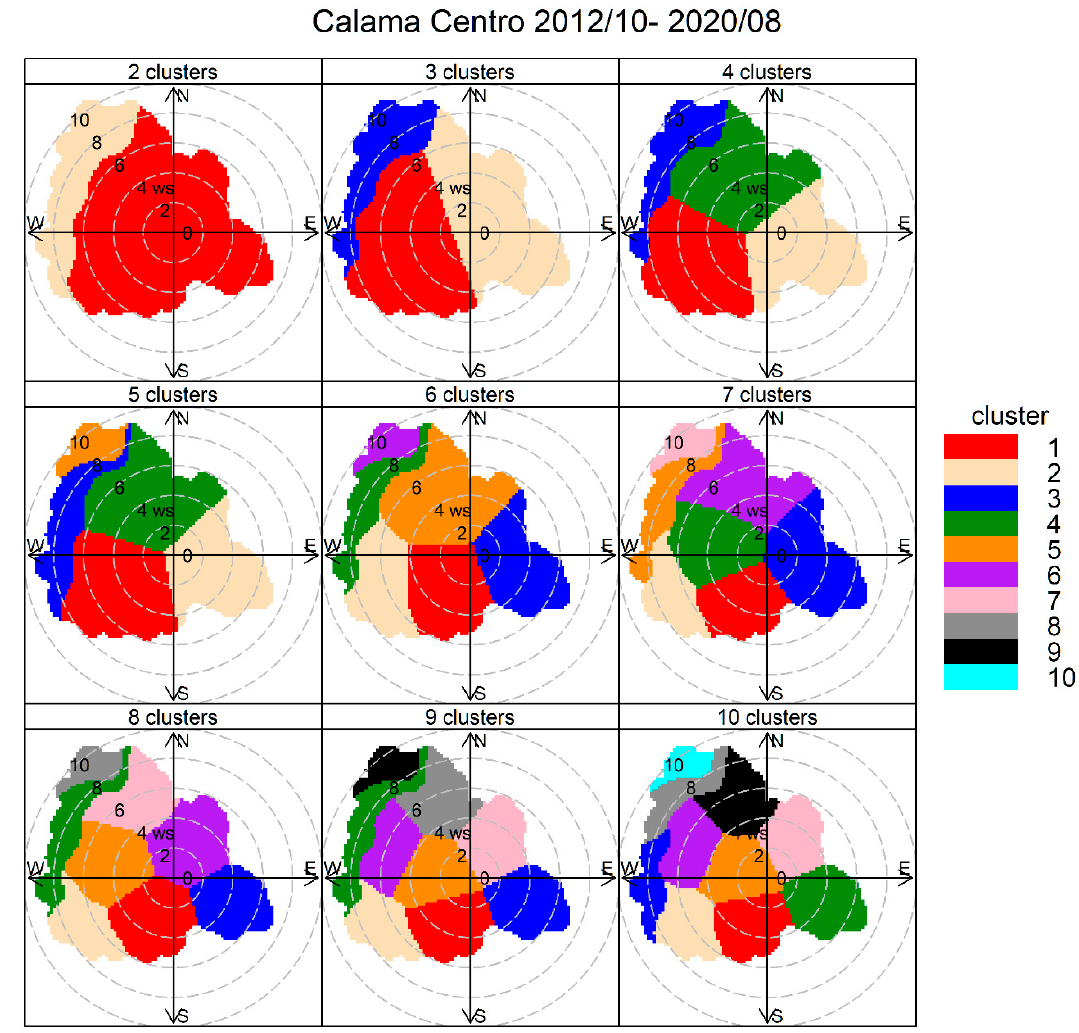
Figure 2. Cluster analysis source apportionment results for ambient PM 10 at Calama, 2012/10–2020/08, for 2–10 clusters solutions. The numbers stand for wind speed levels (m/s).